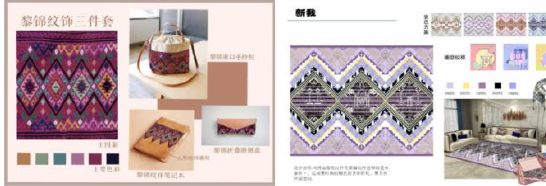
Fig. 2. The Creative Forms and Works of Li Jin Culture in